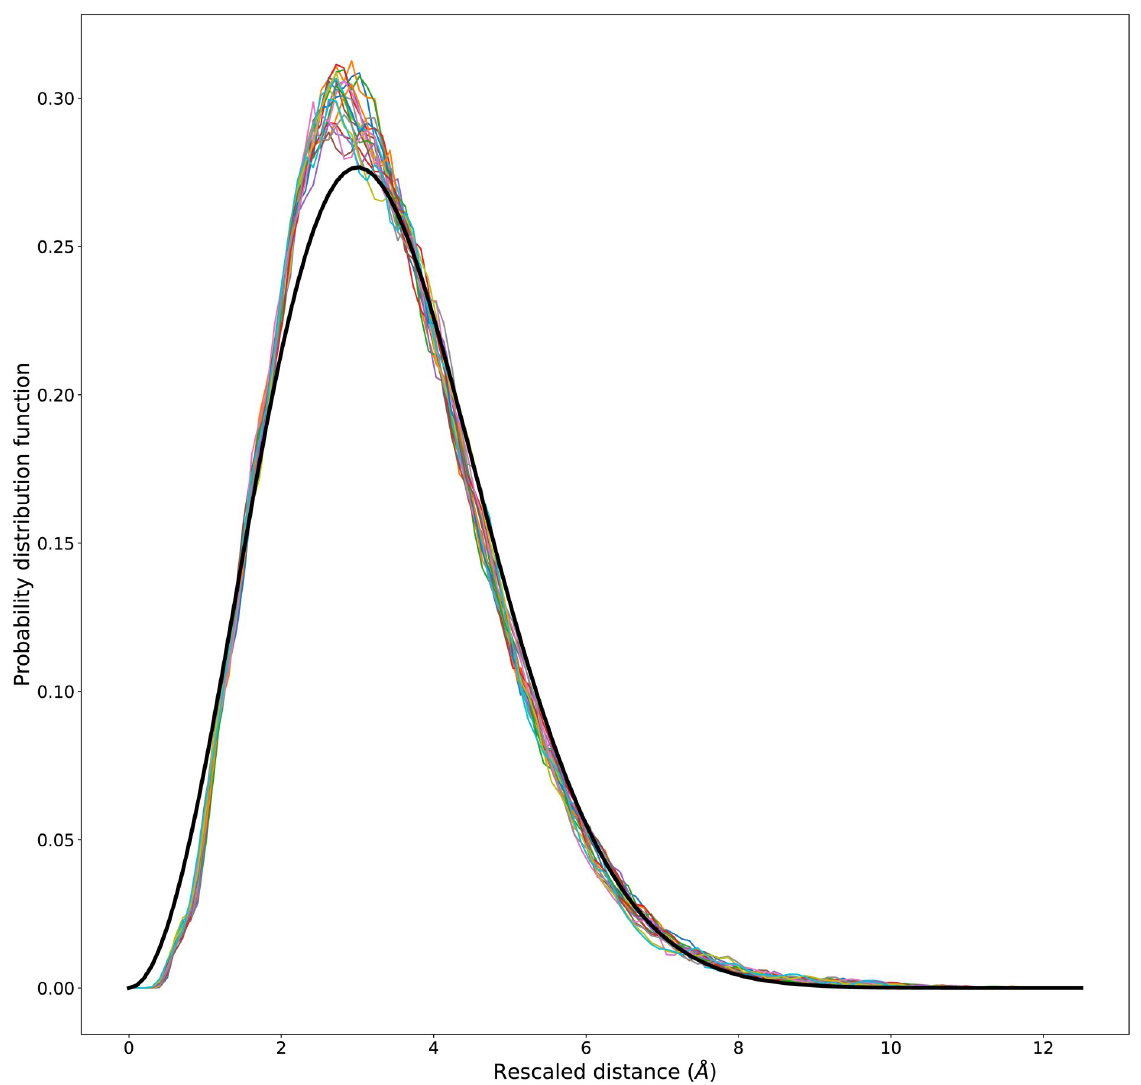
Fig 3. Data collapse of end-to-end distance distributions in the Flory regime for buried fragments. The rescaled empirical probability distributions as a function of the rescaled length R / m 1/2 for 70 � m � 90. All curves collapse rather well together. The reference Maxwell distribution (8) evaluated for the plateau scale parameter b � = 3.67 Å is shown for comparison. A significant deviation appears only for small distances and is due to the effect of excluded volume that at very short range can not disappear for real protein chains. It is worth to notice that, despite the presence of secondary structures, the value of b is close to the average distance, ’ 3.8 Å , found between consecutive C α atoms in protein native structures. Figure drawn with python package matplotlib, version 3.4.1. URL